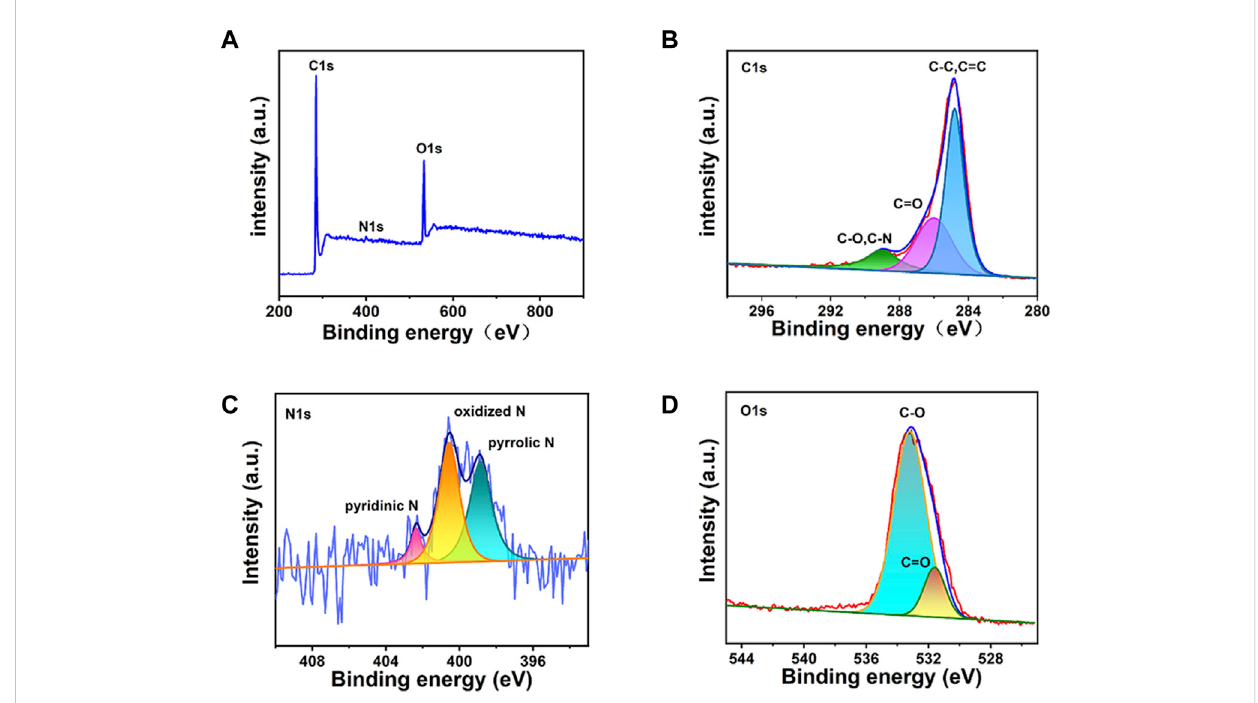
FIGURE 3 The XPS spectra of the CDs: (A) the total spectrum, (B) C1s enlarged region, (C) N1s enlarged region, (D) O1s enlarged